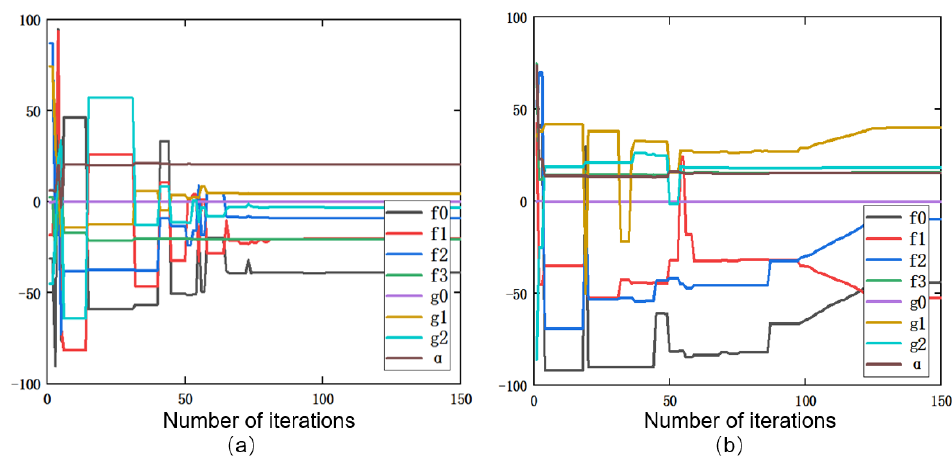
Figure 10. Parameter convergence process of artificial fish swarm algorithm model: ( a ) ascending segment; ( b ) descending segment.